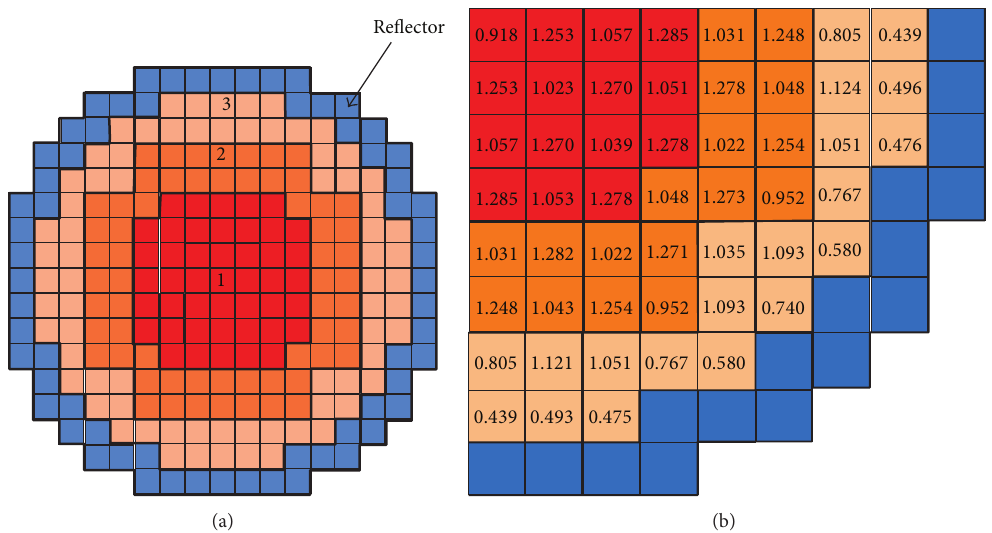
Figure 13: Core zone correspondence (a) and assembly relative power (b)